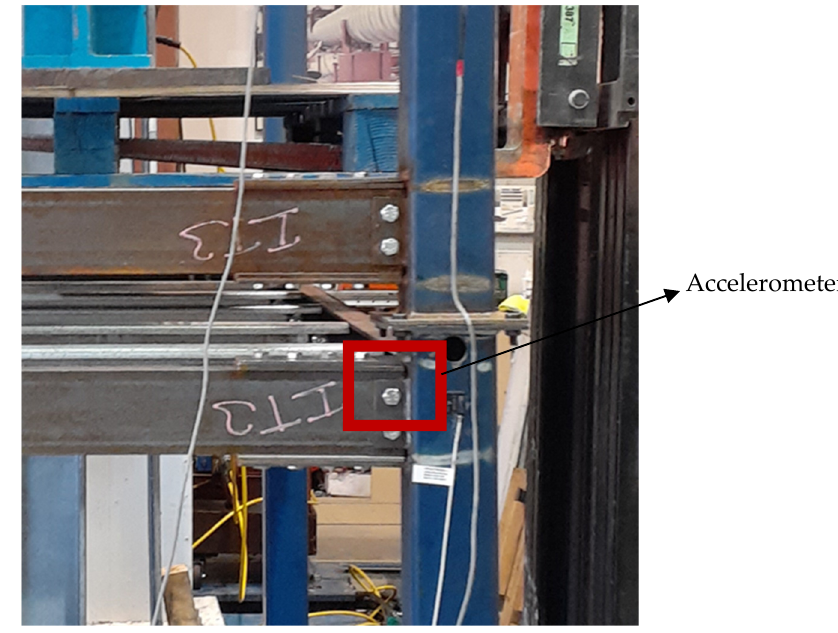
Figure 4. An accelerometer attached to the column of the specimen.